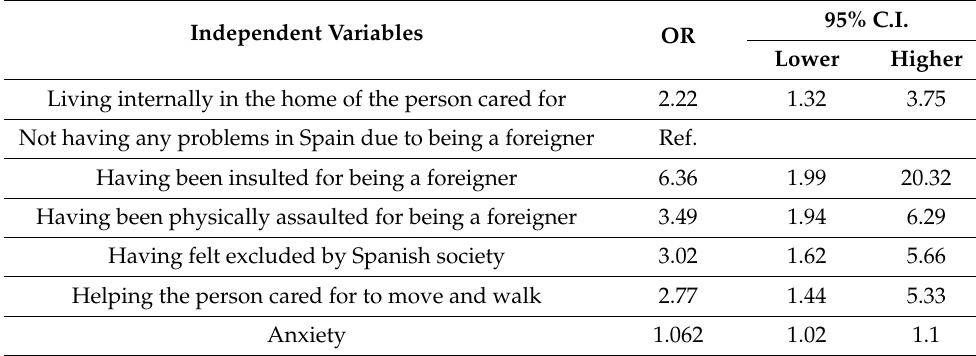
Table 4. Binary logistic regression analysis. Independent Variables OR